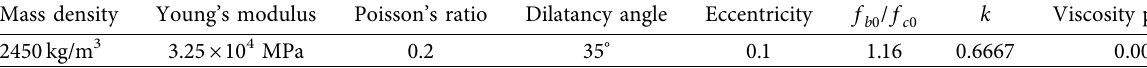
Table 3: Parameter table of concrete damage plasticity model.